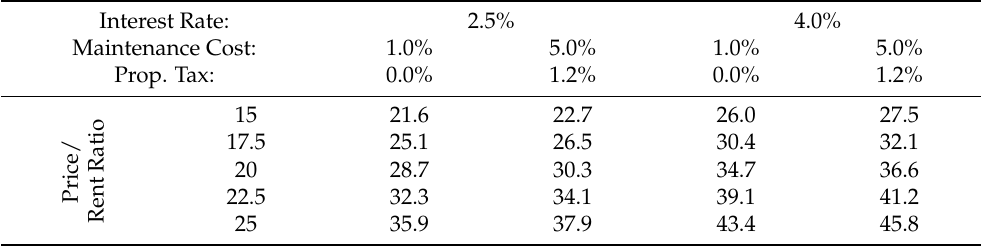
Table 5. Payback time (years) of a leaseback arrangement under differing